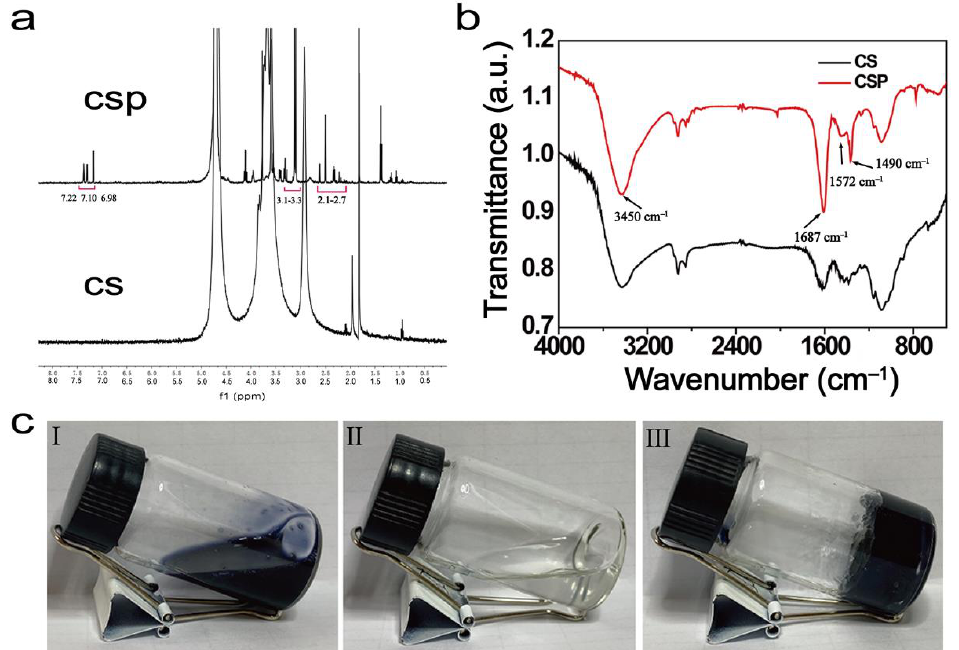
Figure 1. ( a ) 1 H NMR spectra of gel polyaniline-grafted chitosan (CSP) and chitosan (CS) prepared in D 2 O at room temperature. ( b ) FTIR spectra for CSP and CS. ( c ) Digital photographs of the chitosan/polyaniline/laponite (COL) hydrogel formation process. I: CSP solution. II: Oxidized dextran/laponite (OD/LAP) solution. III: COL hydrogel.